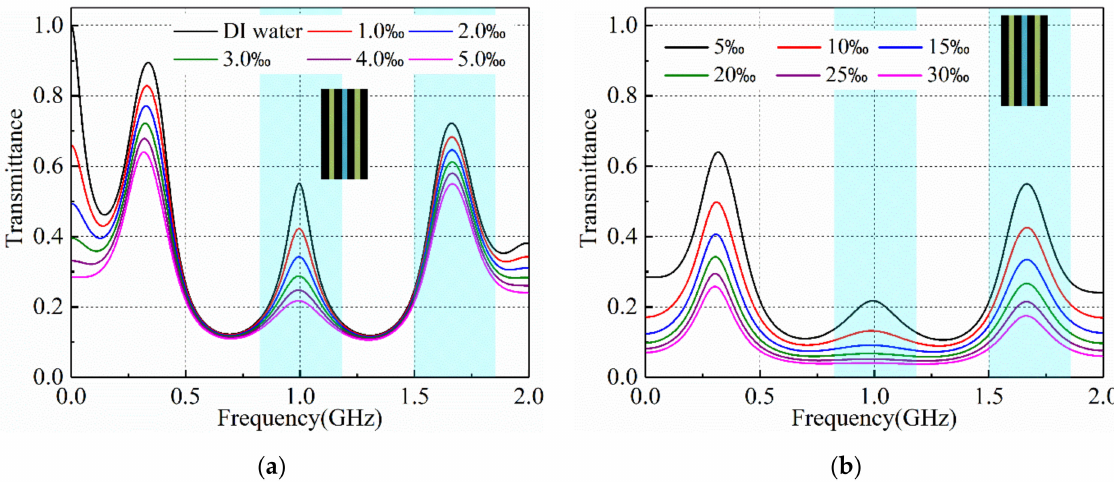
Figure 4. The transmittance spectra of the 7-layer defective MPC sensor with salinity range of ( a ) 0–5‰, ( b ) 5–30‰.